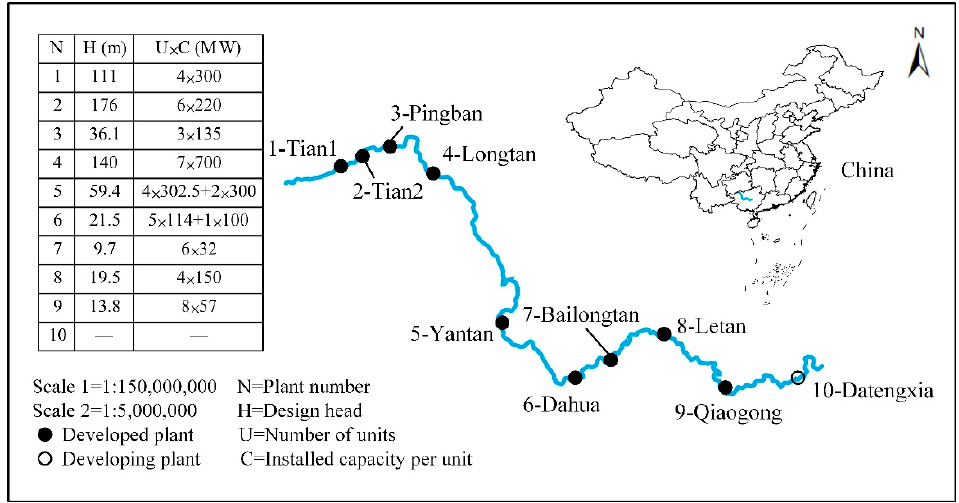
Figure 1. The Hongshui River cascade structure: Scale 1 is the scale of the map; Scale 2 is the scale of the river.